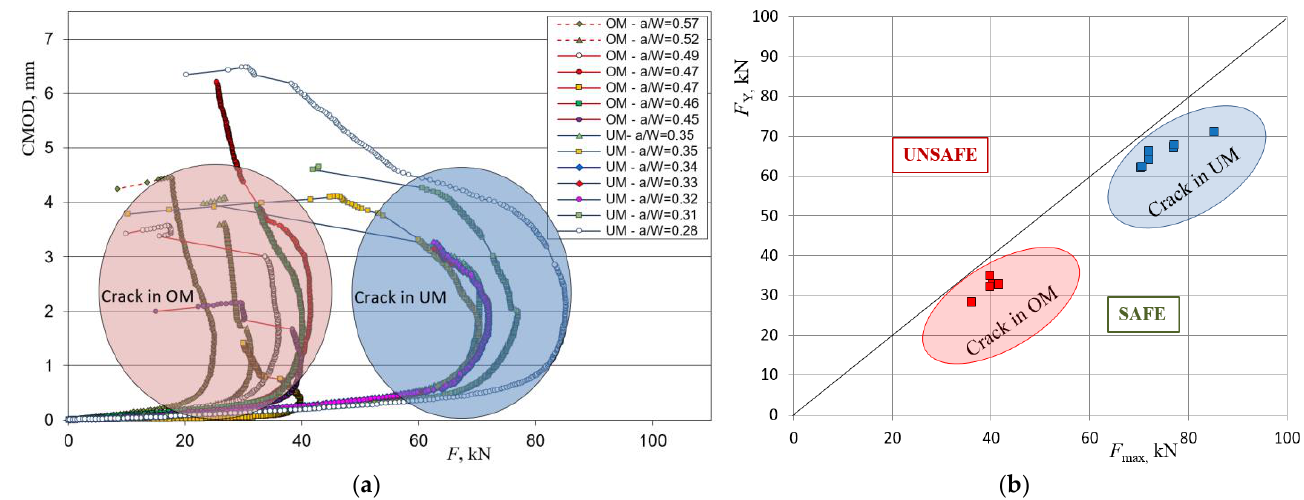
Figure 8. Experimentally obtained results: ( a ) loading curves for specimens with a crack in the OM and UM part of the weld; ( b ) comparison of experimentally obtained maximum load with a yield load obtained by numerical analysis for a crack in the OM and UM part of the weld.